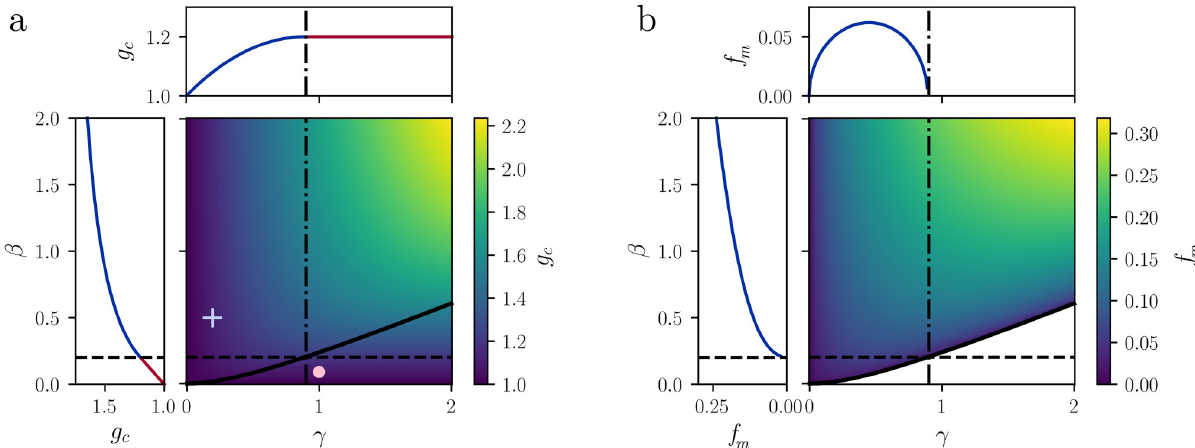
Fig 7. Stability of the fixed point and local properties. a: Critical value of the coupling g c (color code, right) for different adaptation parameters γ (horizontal axis) and β (vertical axis). The curve β ( γ ) (solid black line) separates the regions of the γ − β plane in which for increasing g we encounter a H Hopf bifurcation (above β H ( γ )) or a saddle-node bifurcation (below β H ( γ )). Cross and filled circle: parameters used in Fig 1. Left inset: dependence of g c on β for fixed γ = 0.9. Top inset: dependence of g on γ for fixed β = β ( γ = 0.9). Blue line: Hopf bifurcation; red line: saddle-node bifurcation. b: c H Resonance frequency f m for different adaptation parameters γ , β . Notice that in the non-resonant region the resonance frequency is not defined. Left as a function of β for fixed γ = 0.9. Top inset: non-monotonic behavior of f as a function of γ , for fixed β = β ( γ = 0.9). inset: square-root increase of f m m H